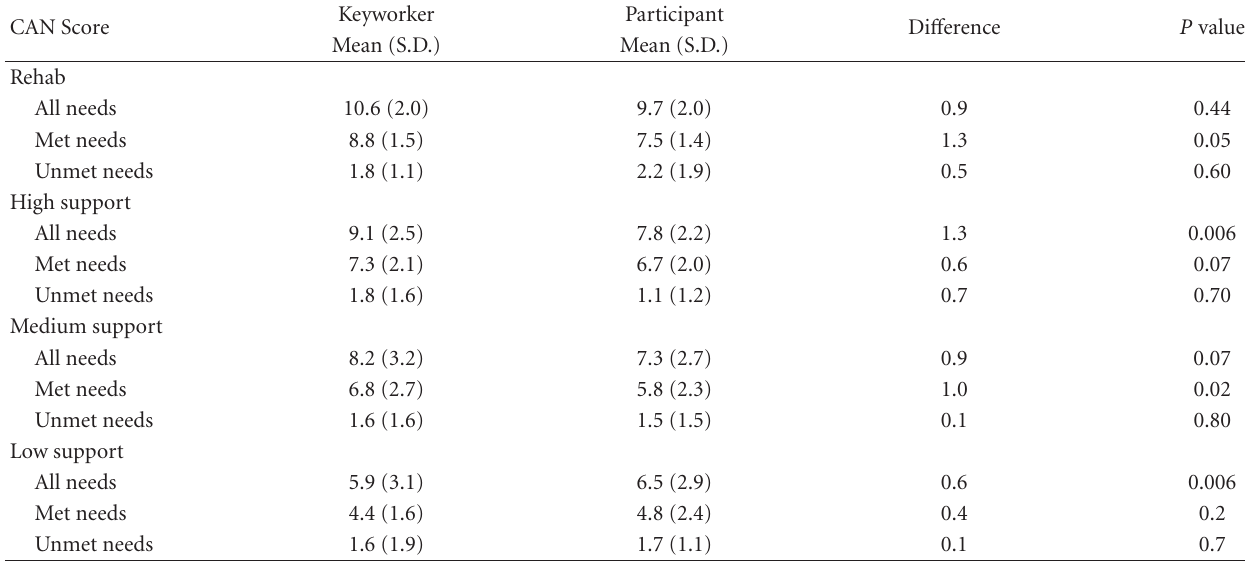
Table 3: Comparison of the mean total needs, met and unmet needs in all housing types (Wilcoxon-matched pairs signed-rank test). CAN Score